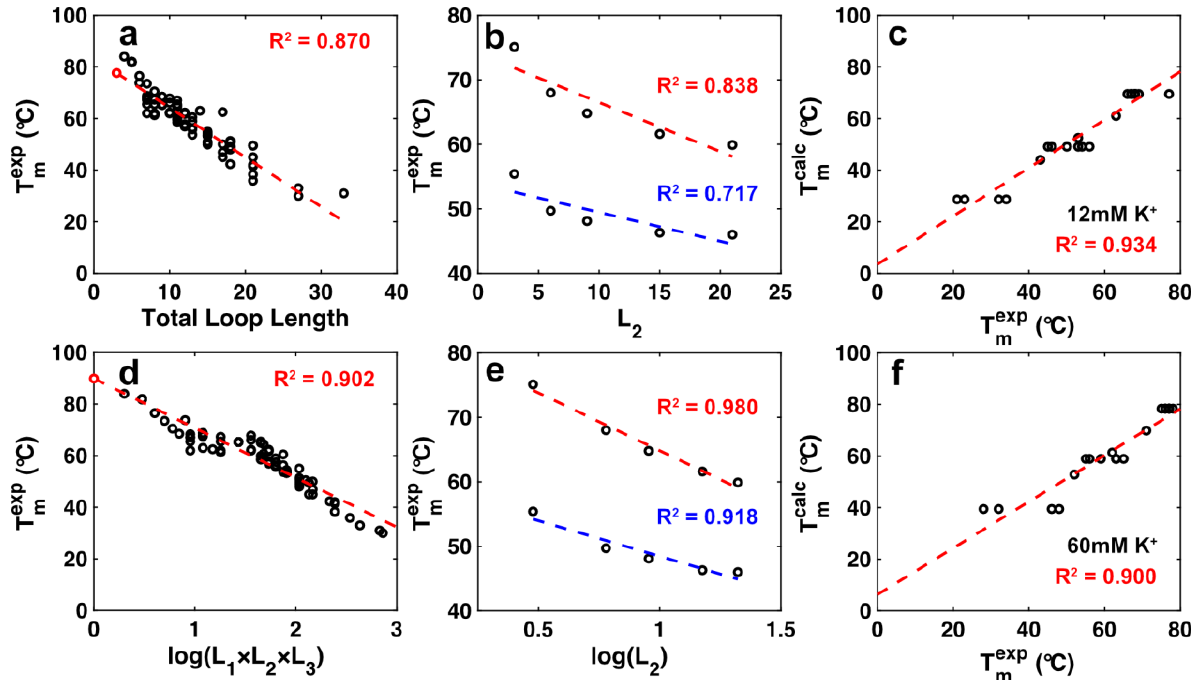
Figure 2. ( a ) Dependence of experimental T m on total loop length. ( b ) Dependence of experimental T m on the length of L 2 for L 1 ,L 3 = TTT (blue) and L 1 ,L 3 = T (red). ( c ) Correlation between experimental and predicted T m values for bulges of different lengths in 12 mM potassium according to Equation (3). ( d ) Dependence of experimental T m on the logarithm of the product of the loop lengths. ( e ) Dependence of experimental T m on the logarithm of the product of the loop lengths for L 1 ,L 3 = TTT (blue) and L 1 ,L 3 = T (red). ( f ) Correlation between experimental and predicted T m values for bulges of different lengths in 60 mM potassium according to Equation (3). Data in ( a , b , d , e ) taken from [52]. Data in ( c , f ) taken from [14].